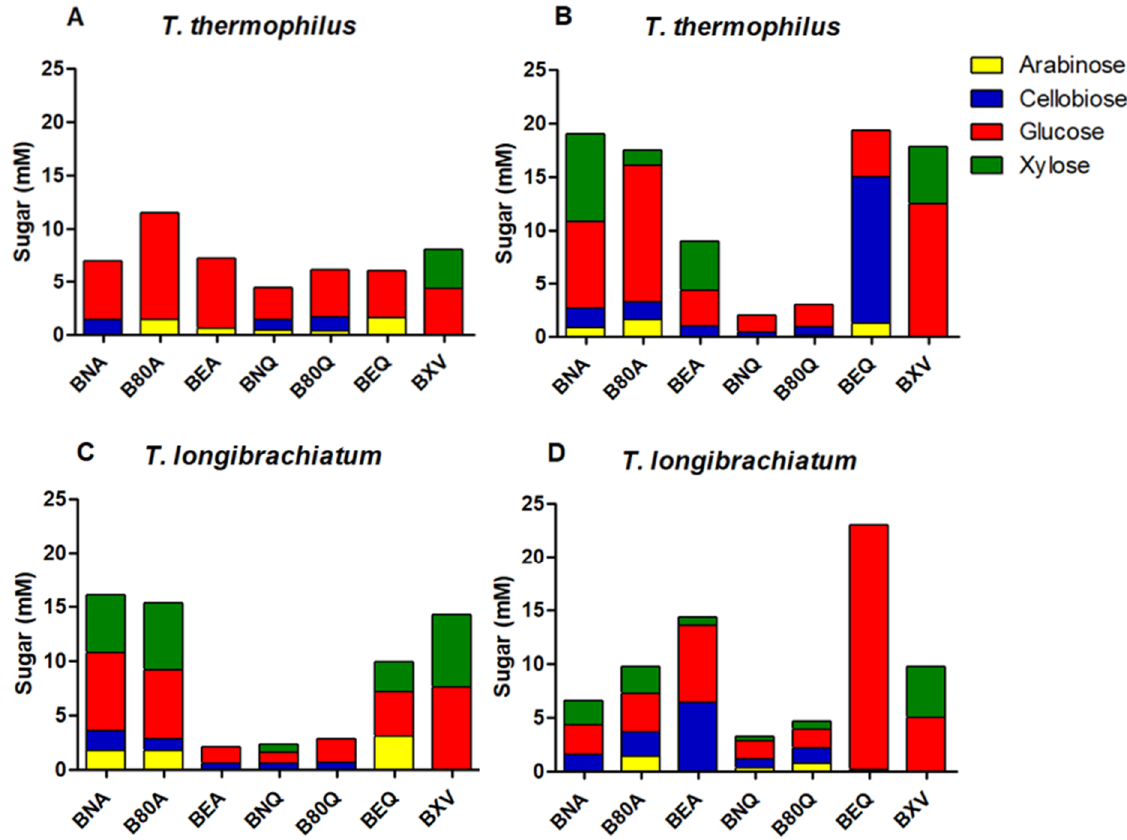
Figure 3. Sugars content in hydrolysates. BNA: sugarcane bagasse pretreated by autohydrolysis; B80A: SP80-3280 sugarcane culm pretreated by autohydrolysis; BEA: culms of energy cane pretreated by autohydrolysis; BNQ: sugarcane bagasse pretreated chemically; B80Q: SP80-3280 sugarcane culm pretreated chemically; BEQ: culms of energy cane pretreated chemically; BXV: steam explosion sugarcane bagasse. ( A , B ) values of T. thermophiles ; ( C , D ) values of T. longibrachiatum.